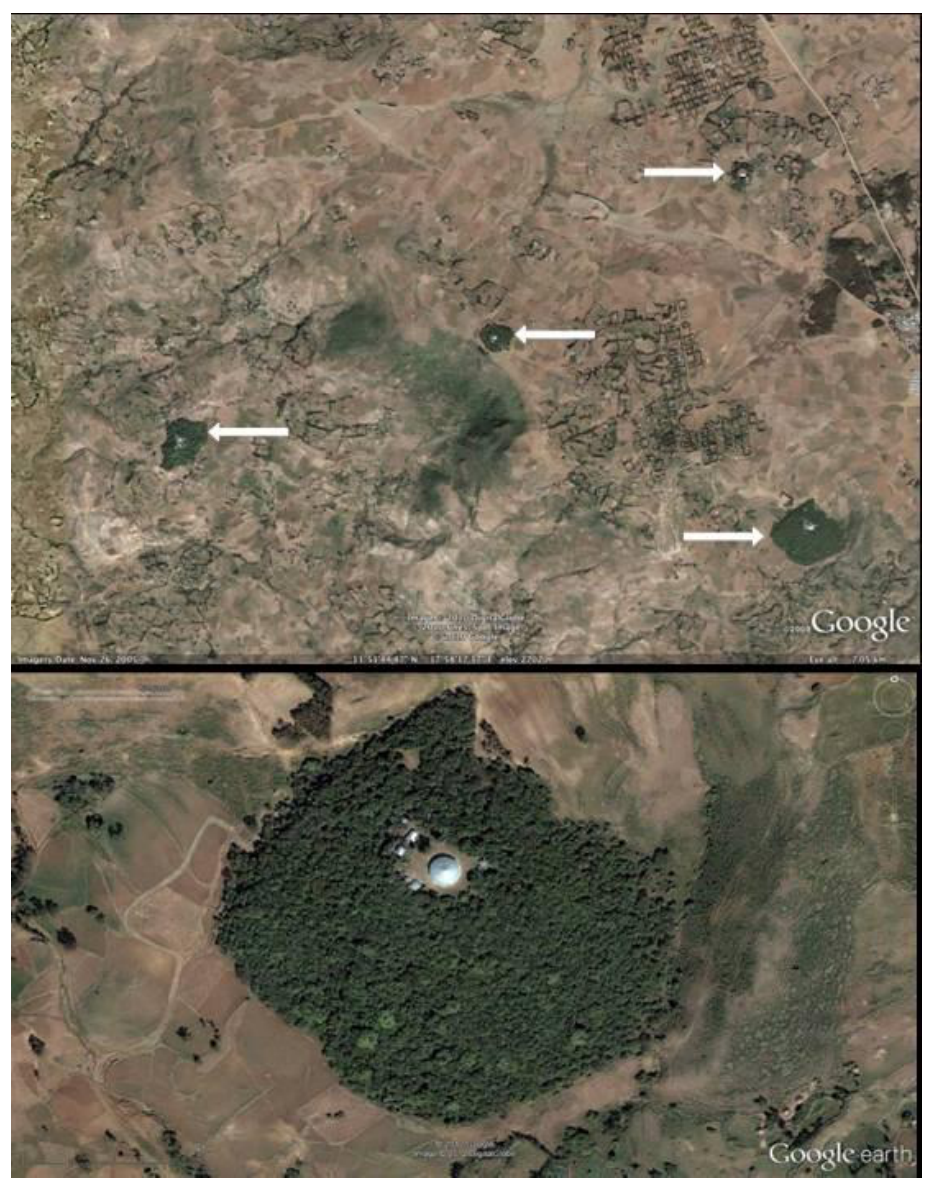
Figure 2. ( a ) GoogleEarth image of study site Debresena (lower right) and other sacred groves. Arrows point to forest. ( b ) GoogleEarth image of one study forest, Debresena. The round Building in the center of the grove is the